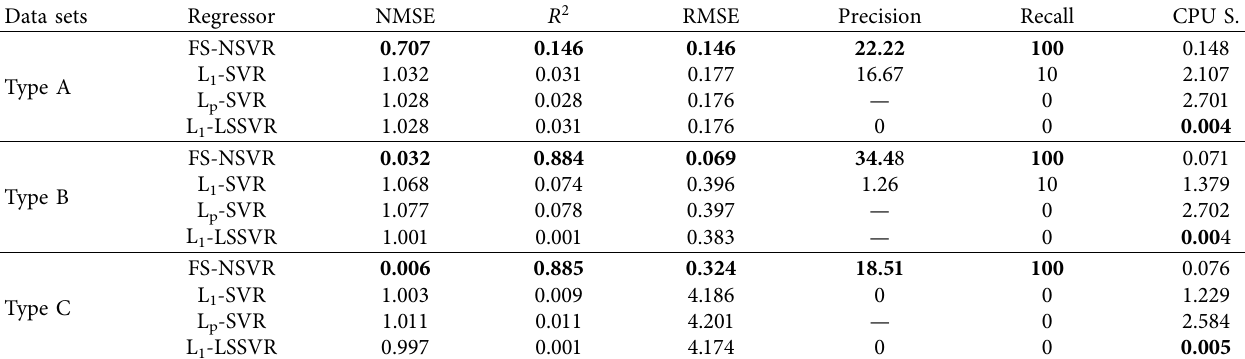
Table 4: Te optimal parameters of real-world datasets.